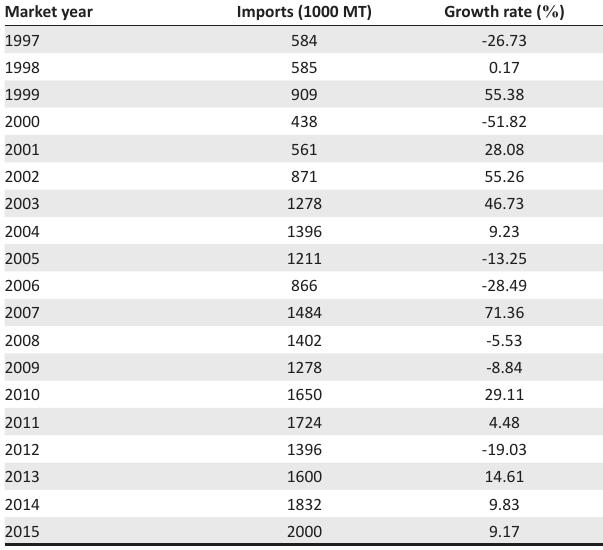
TABLE 4: Imports and exports of soya beans from 2004 to 2015. Market year